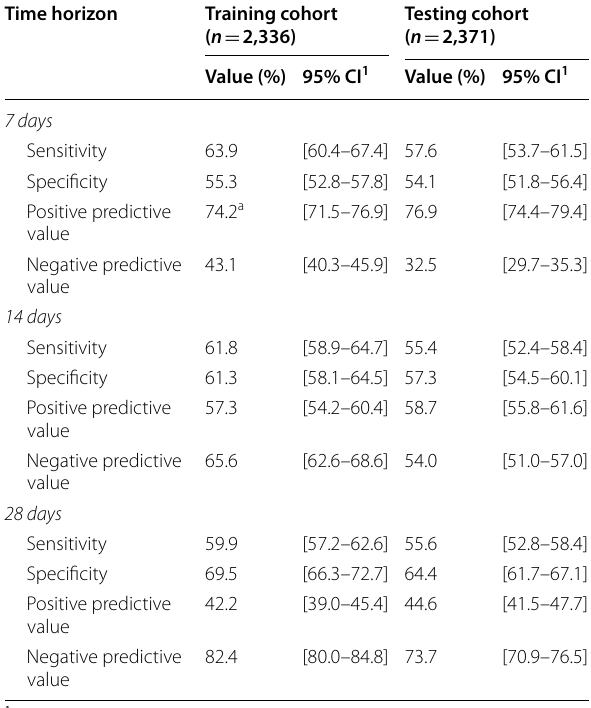
Table 3 Sensitivity, specificity, positive and negative predictive values at different time horizons for CVC‑IN score the training and testing